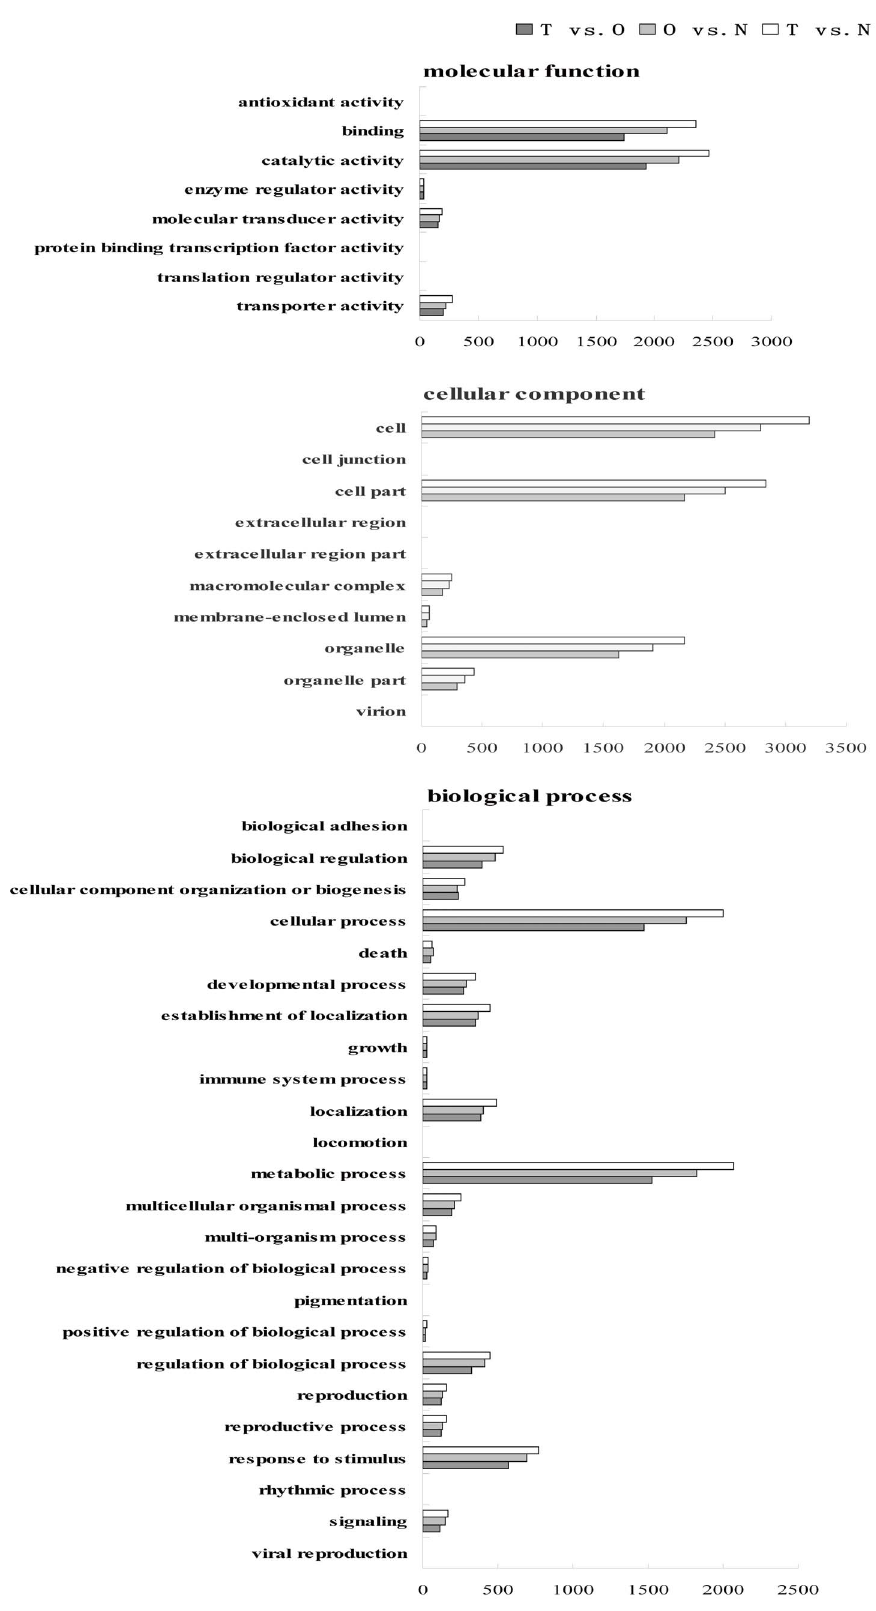
Figure 3. Gene ontology (GO) categories assigned to differentially expressed genes in response to artificial bending. The x-axis shows the number of unigenes, and the y-axis shows the GO subcategories.